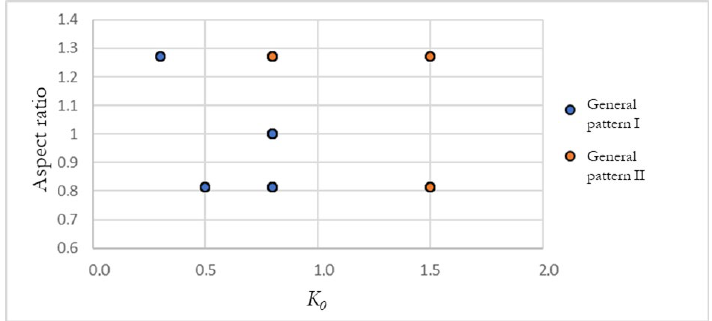
Figure 10. Normalized load distribution pattern depending on section’s aspect ratio and 0 K